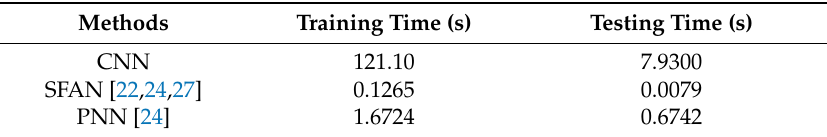
Table 4. Comparison among consumption times for: CNN, PNN, and